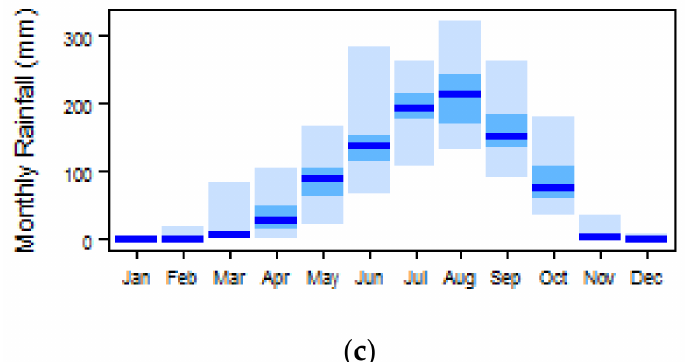
Figure 2. Average rainfall amounts in different climatic regions of Sudan [5] ( x -axis shows month of year and y -axis show monthly rainfall in mm): ( a ) rainfall in arid/desert (BWh) regions; ( b ) rainfall in semi-desert (BSh) regions; ( c ) rainfall in tropical savanna (Aw)